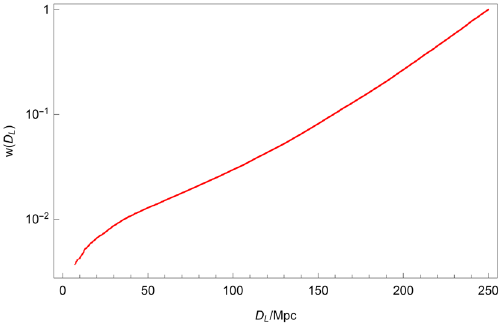
Fig. 5 The weight function w( D L ) accounting for the incompleteness of the flux-limited 2MRS (2019) catalog